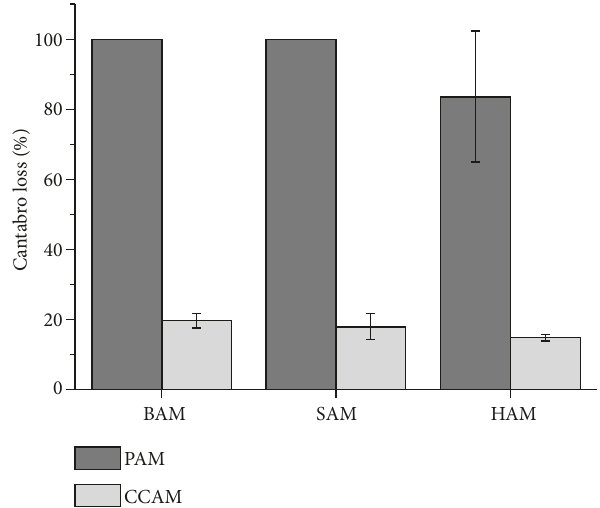
Figure 6: Cantabro losses of mixtures before and after grouting.